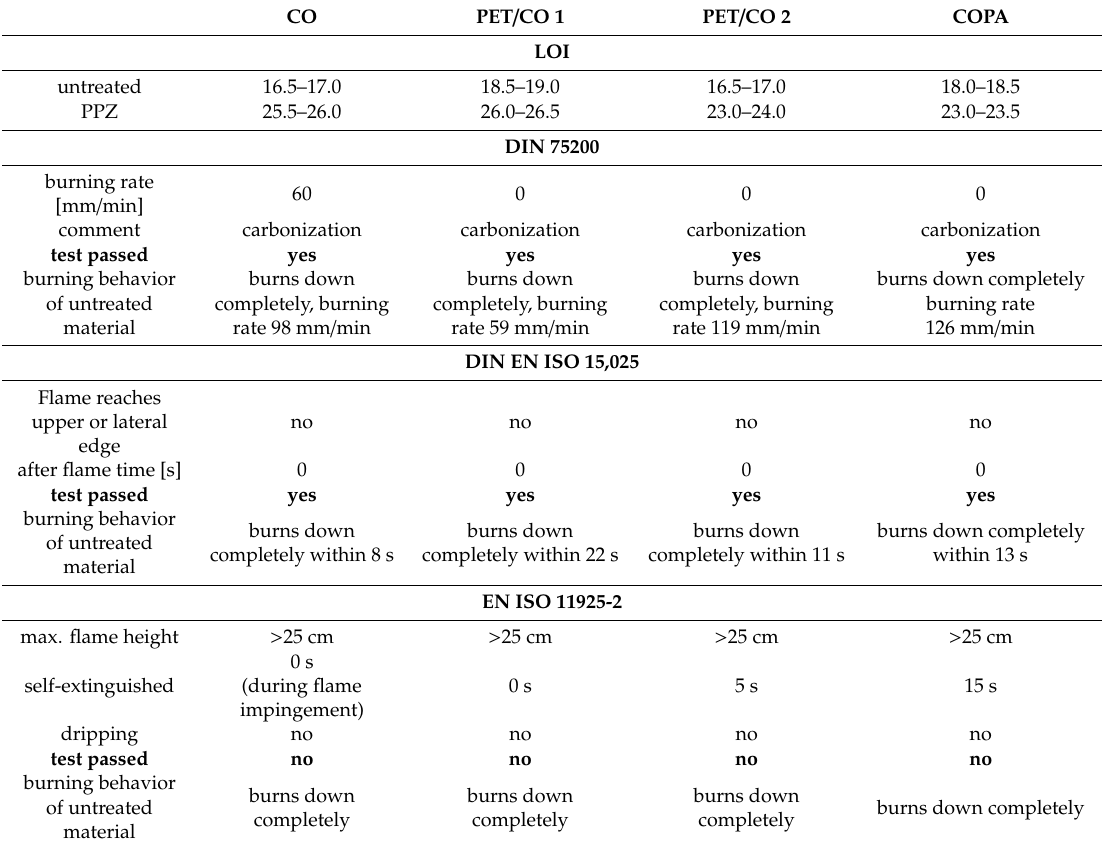
Table 4. Results of the limiting oxygen index (LOI) measurements and the standardized burning tests on CPZ-modified